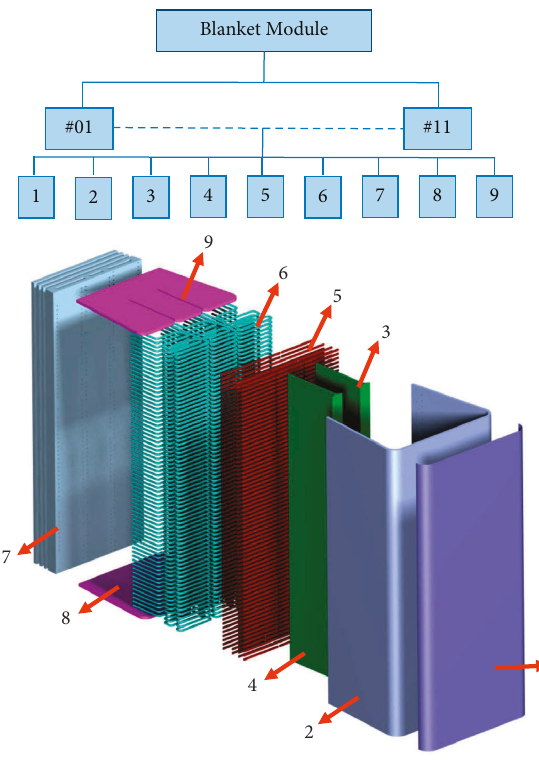
Figure 4: The blanket module for DFA.